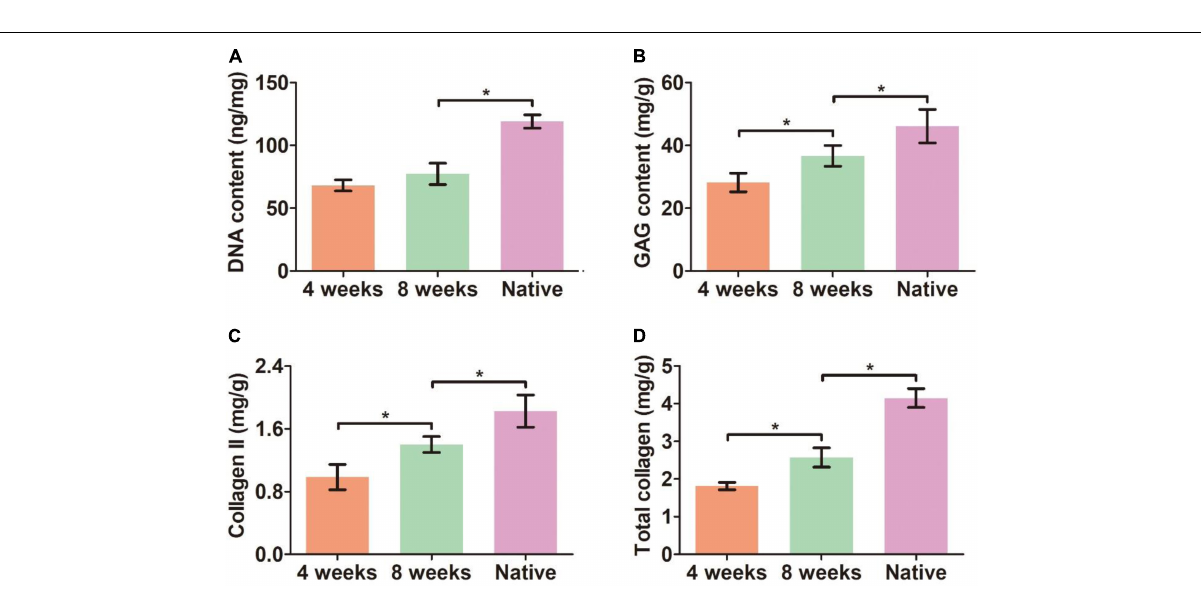
Frontiers in Cell and Developmental Biology |